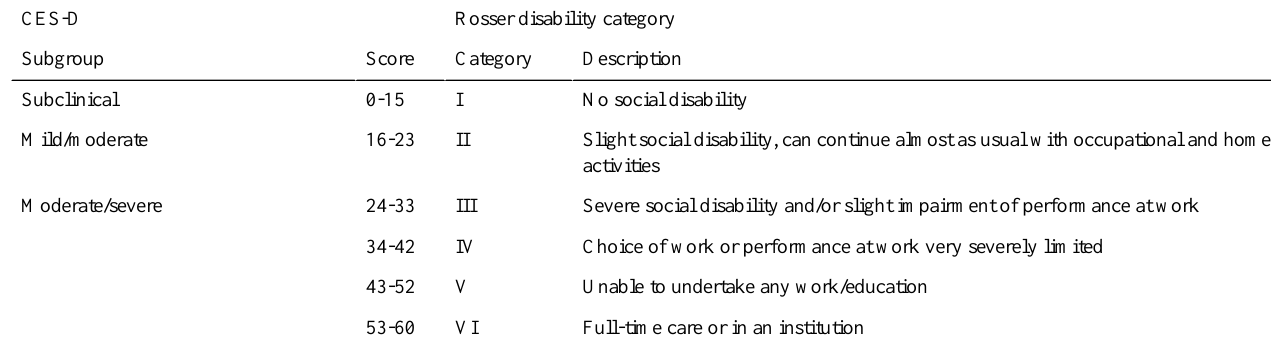
Table 1. Center for Epidemiologic Studies Depression scale (CES-D) scores and their corresponding Rosser disability categories.